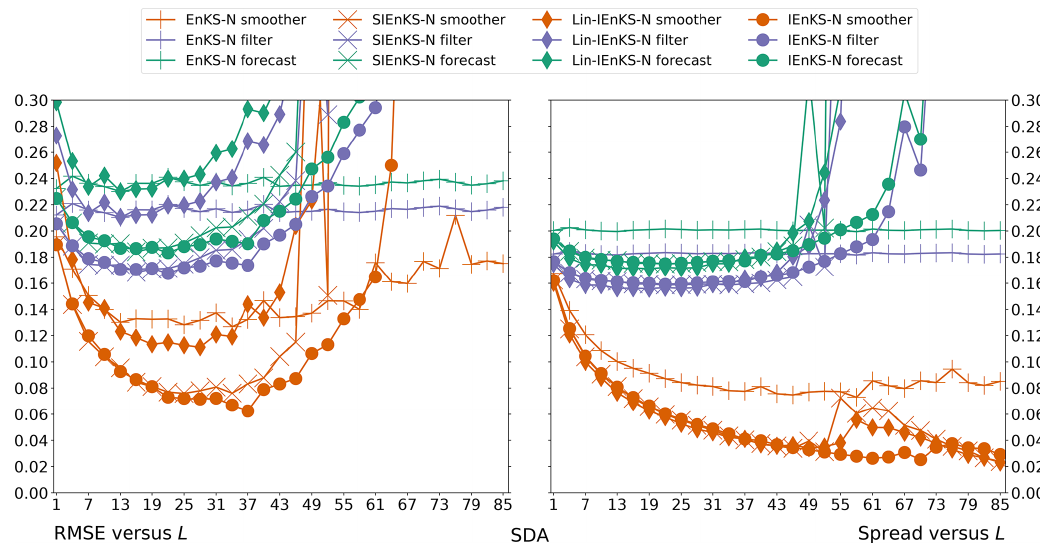
Figure 9. Cross section of Fig. 8 at the ensemble size N e =